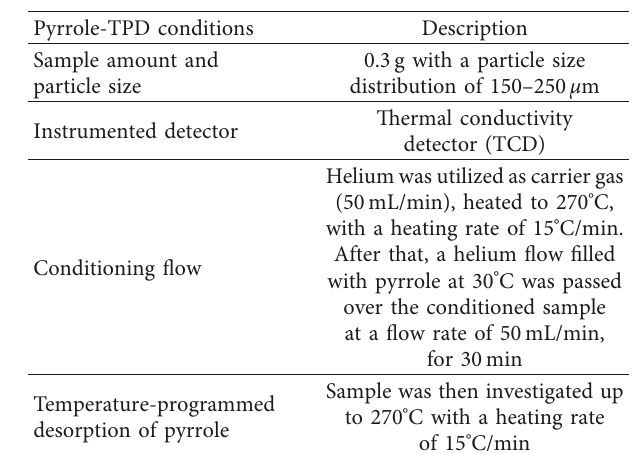
Figure 1: Experimental findings of TPD peaks of pyrrole on grey kaolin samples heated to 150 ° C at different holding